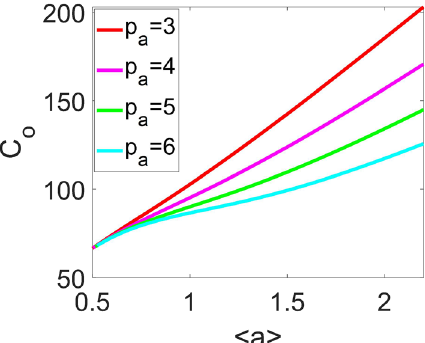
Fig. 10 Three-dimensional graphic for the evolution of the wave packet. The parameters are taken as: p a = 5, α = 0 . 5, V 0 = 200 Fig. 12 Variations in the coherence versus the average value of the